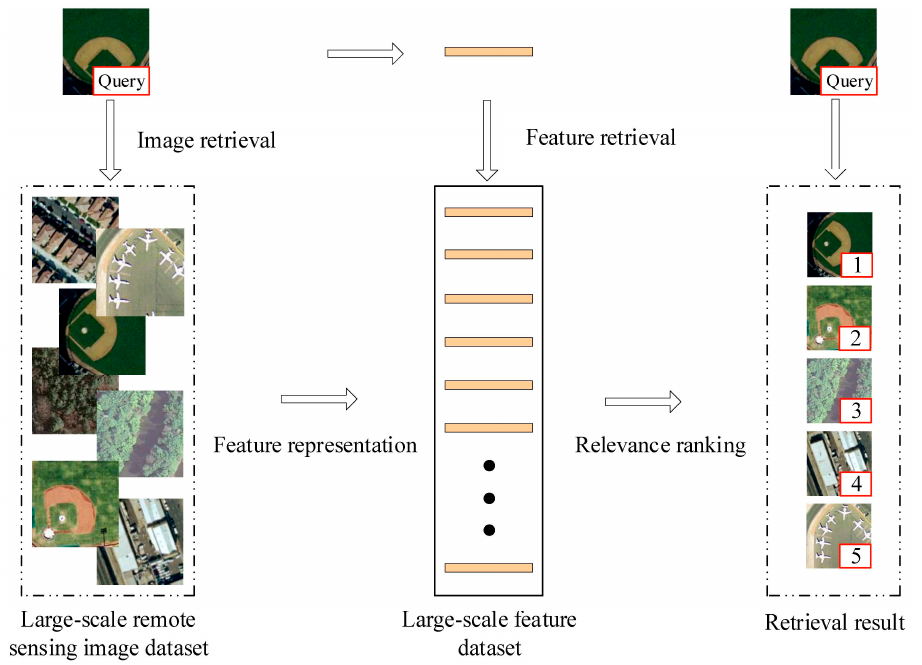
Figure 3. Flowchart of remote sensing image scene retrieval (RSISR). The input remote sensing (RS) scene datasets are trained in deep networks. After feature hashing, which is aimed to reduce dimension, and the first similarity matching from large-scale images, relevance ranking can be further achieved according to the similarity among the query image and retrieved images.